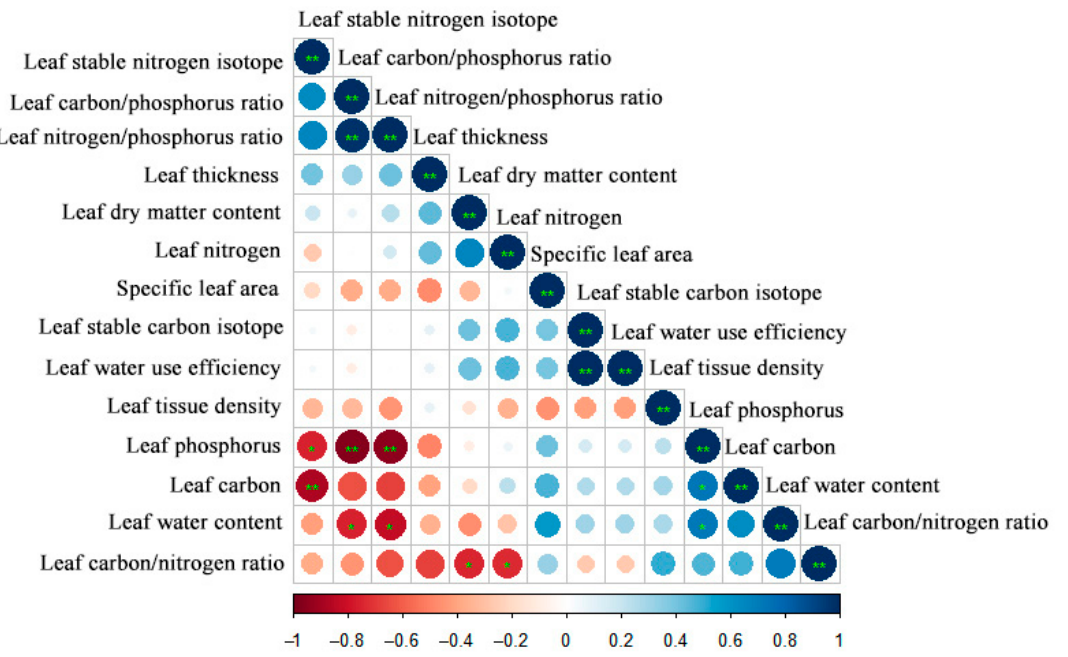
Figure 2. Conceptual illustration of leaf economics spectrum [27,28].